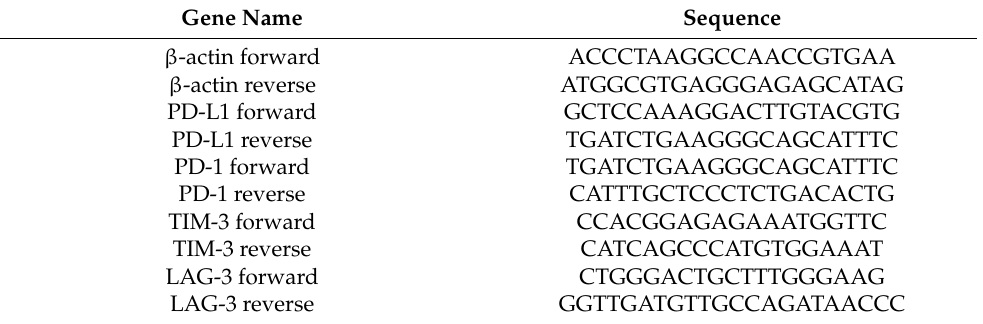
Table 1. Primer sequences of real-time